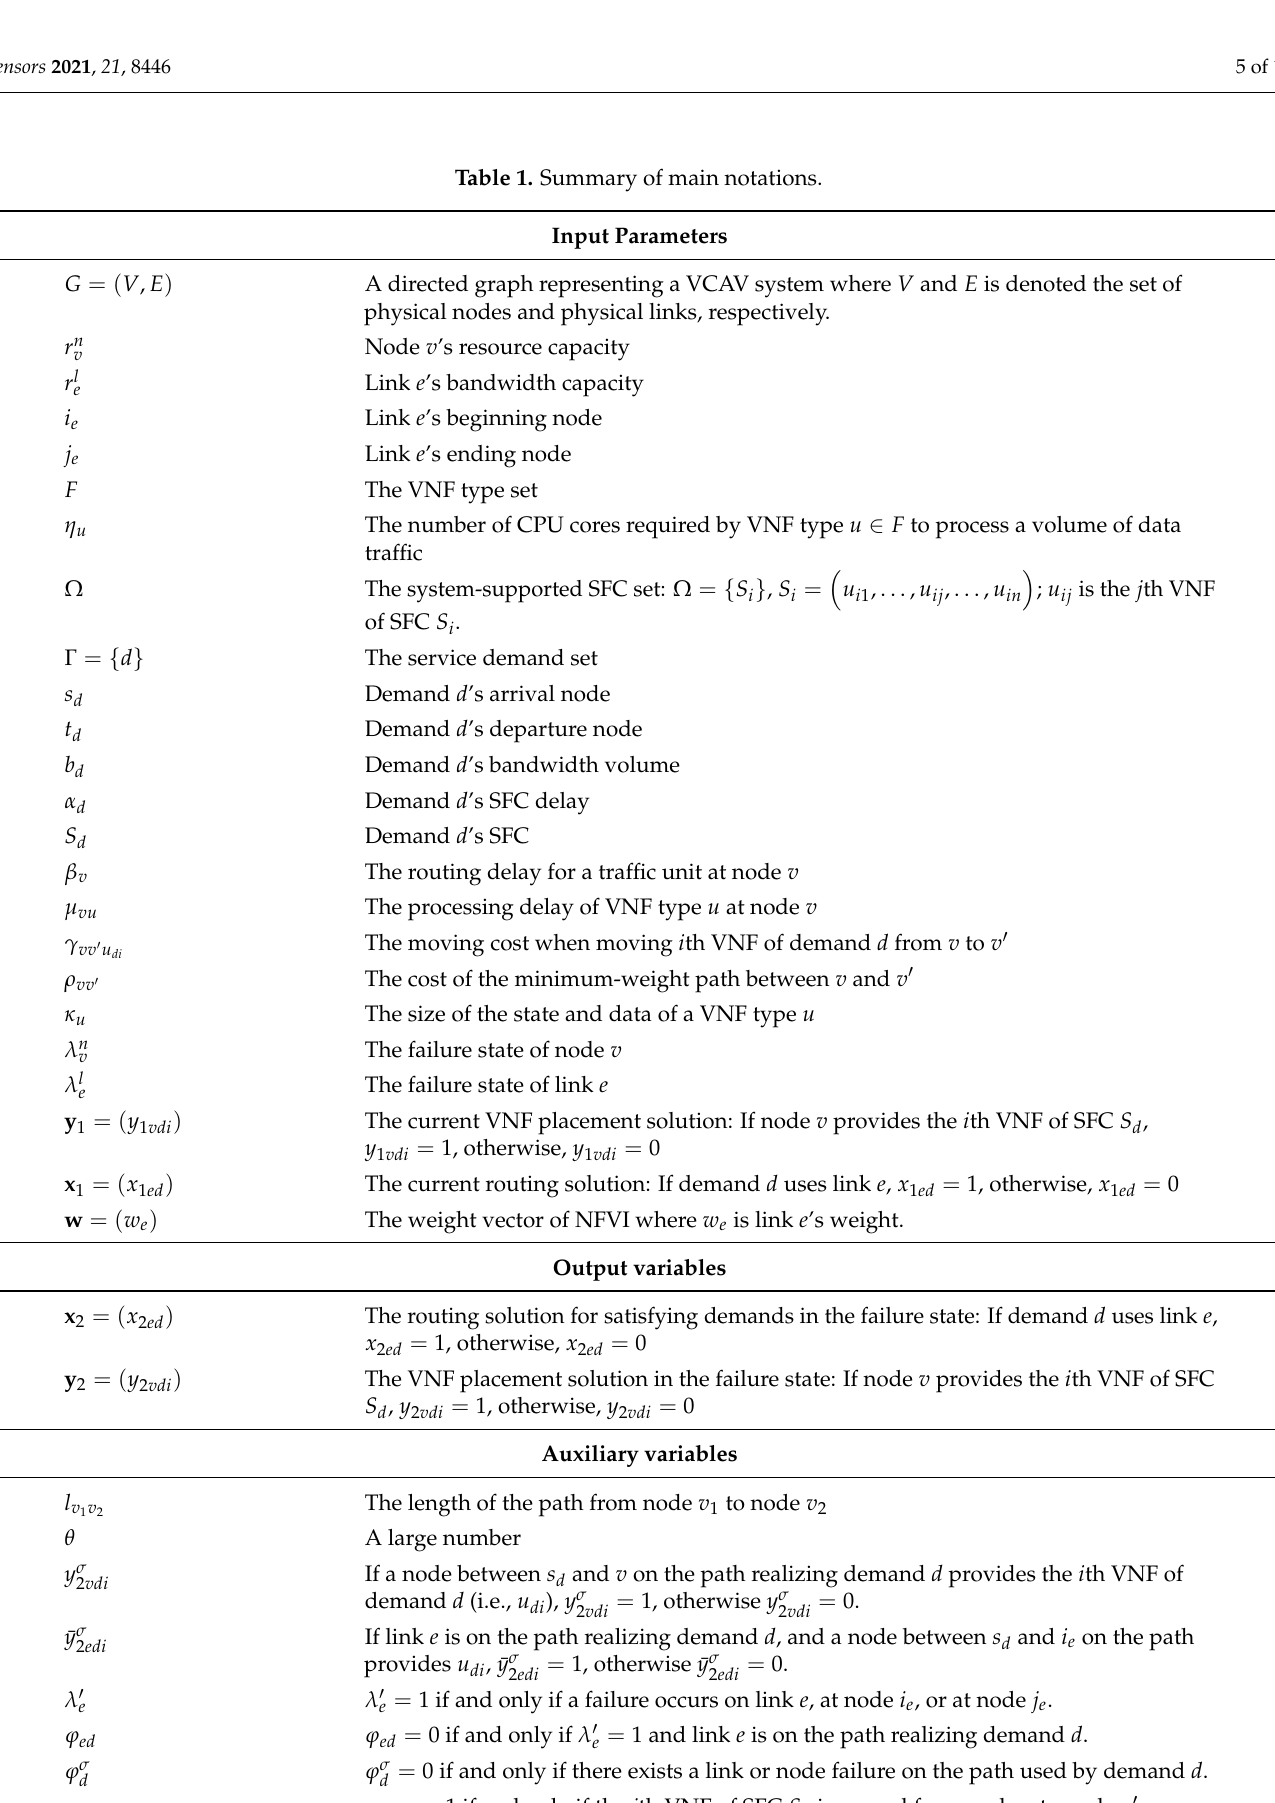
Table 1. Summary of main